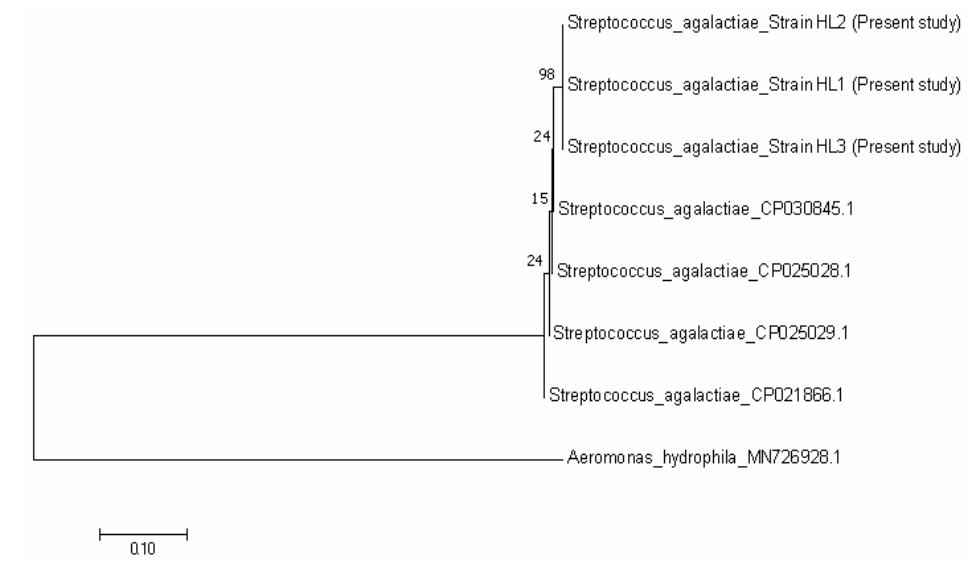
Figure 7. Phylogenetic tree showing the relationship between the three Streptococcus agalactiae sequences from the present study, with other reference sequences from Brazil (CP030845.1) and Singapore (CP025028.1, CP025029.1 and CP021866.1). The tree is based on the 352 bp cpsG gene of S. agalactiae . Aeromonas hydrophila was considered as an out group.